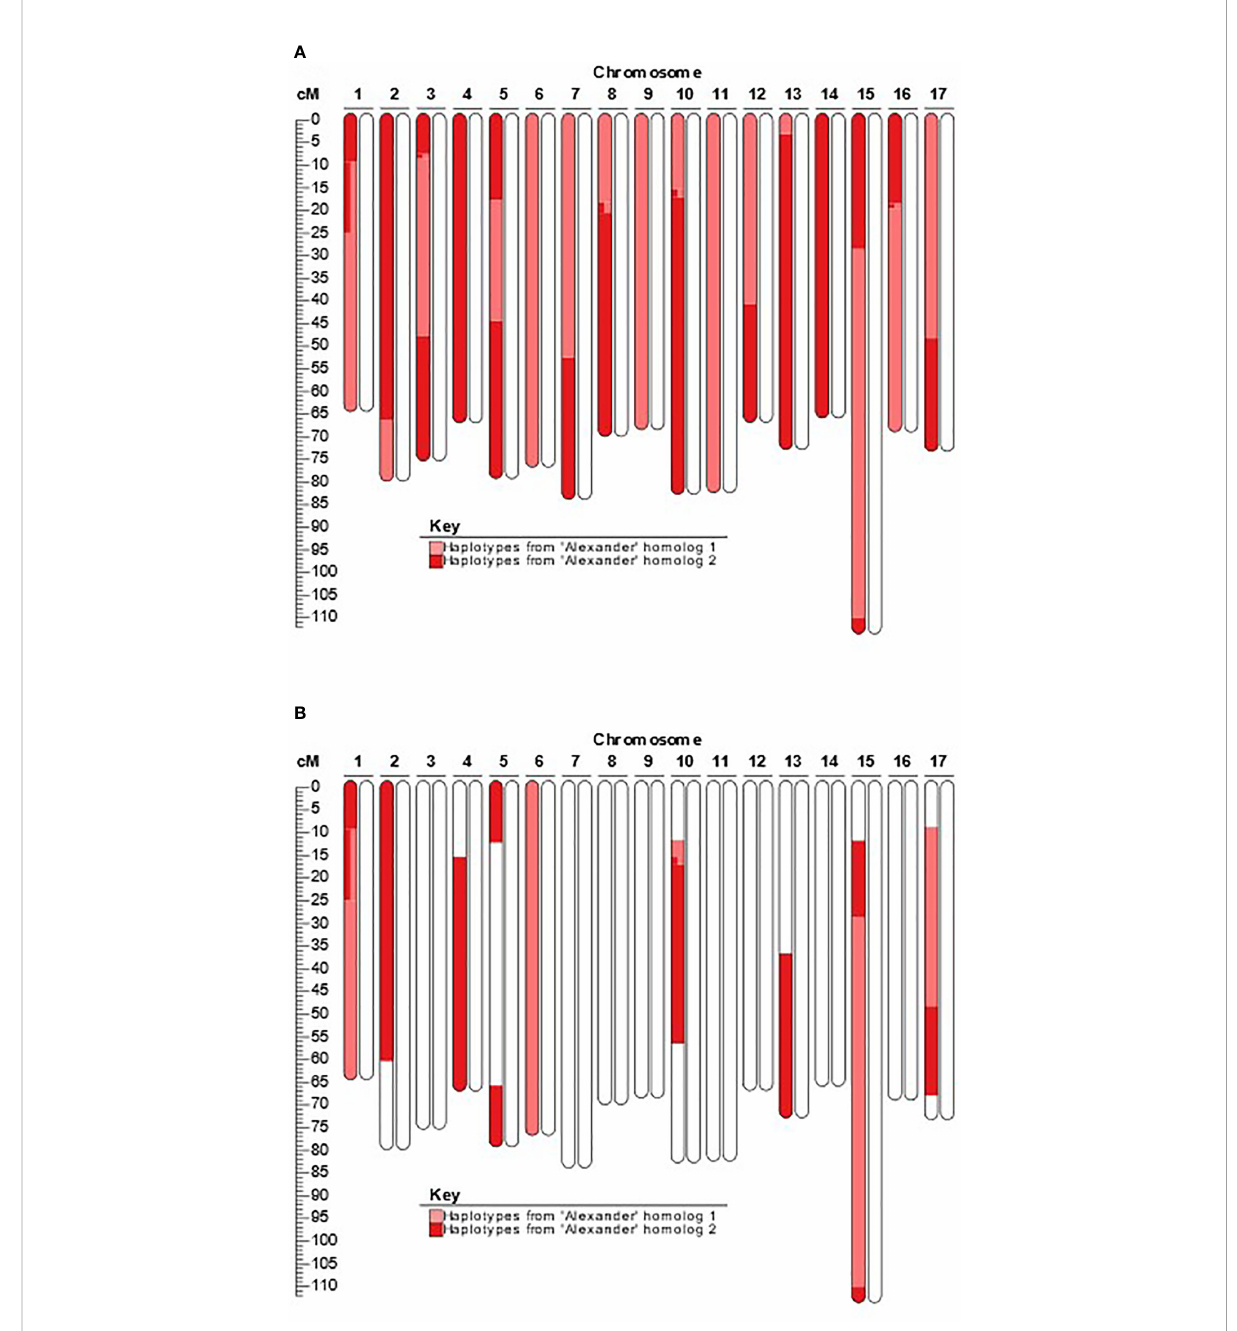
FIGURE 1 Example of newly detected presence of recent M. domestica ancestry in accessions previously labeled as pure wild progenitor species. (A) . Extended shared haplotypes of ‘ Alexander ’ present in the M. domestica - M. sieversii hybrid accession PI 613979; (B) Extended shared haplotypes of ‘ Alexander ’ present in the M. domestica - M. sieversii hybrid accession PI